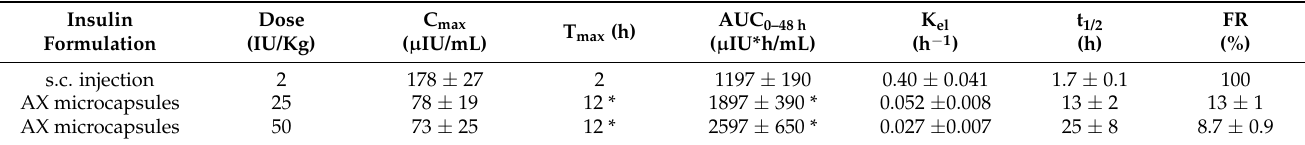
Table 3. Pharmacokinetics parameters for serum insulin levels in the diabetic rat model. Insulin